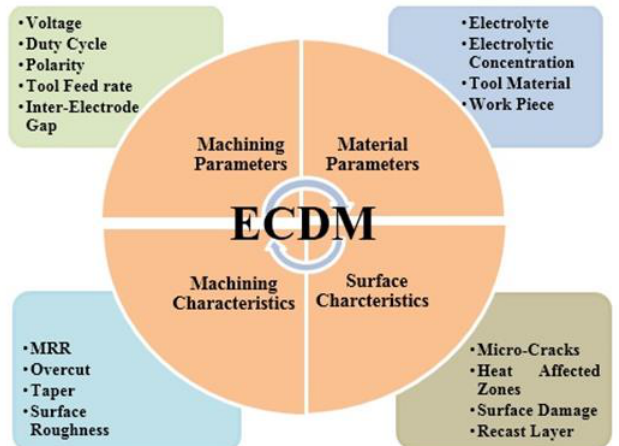
Figure 2. Process variables and output quality characteristics.